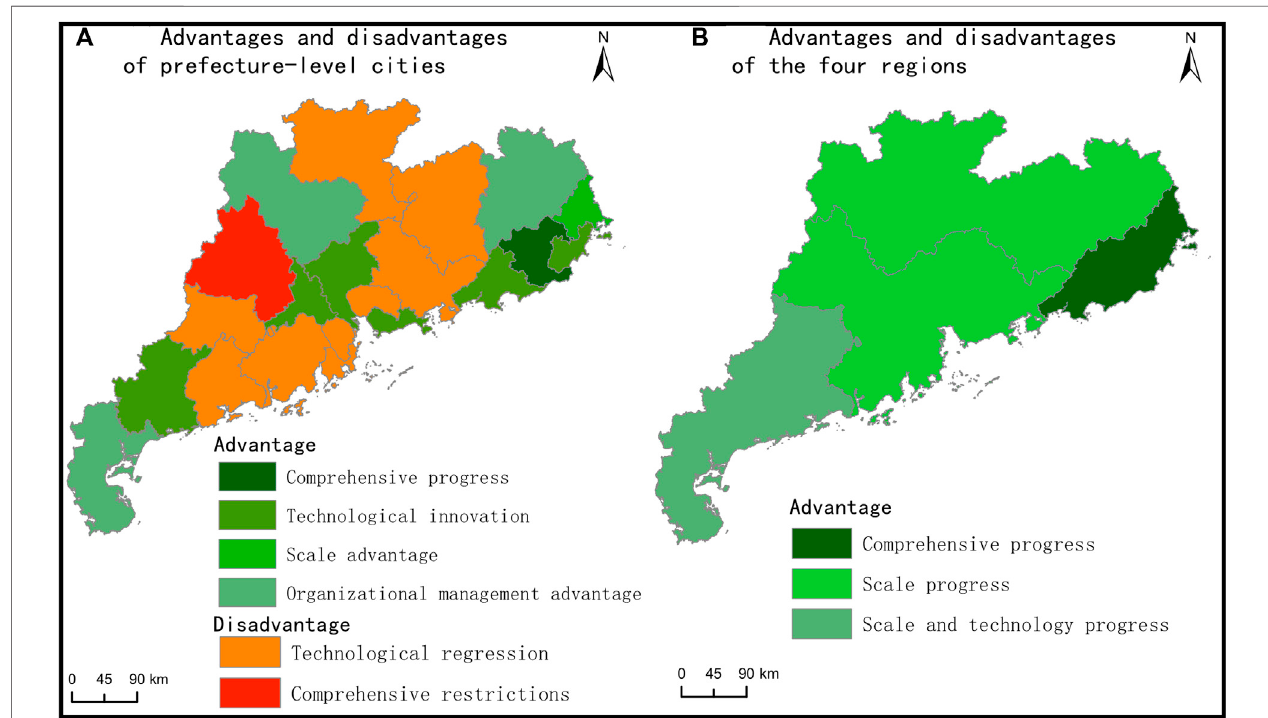
FIGURE 5 | Malmquist index and decomposition trend map of water resource utilization in prefecture-level cities in Guangdong Province in the last 7 years.